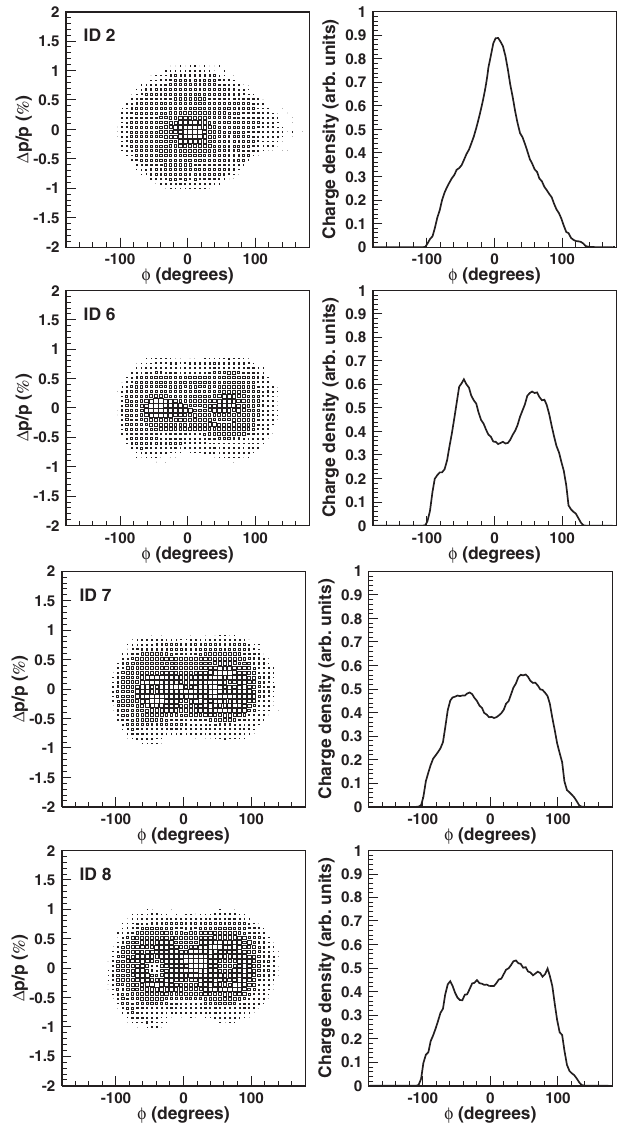
FIG. 9. Particle distributions on the longitudinal phase space ð ϕ ; Δ p=p Þ and their projections onto the ϕ axis, calculated at the end of injection for the beam intensity of 539 kW with the painting parameter IDs 2, 6, 7 and 8 in Table. II given